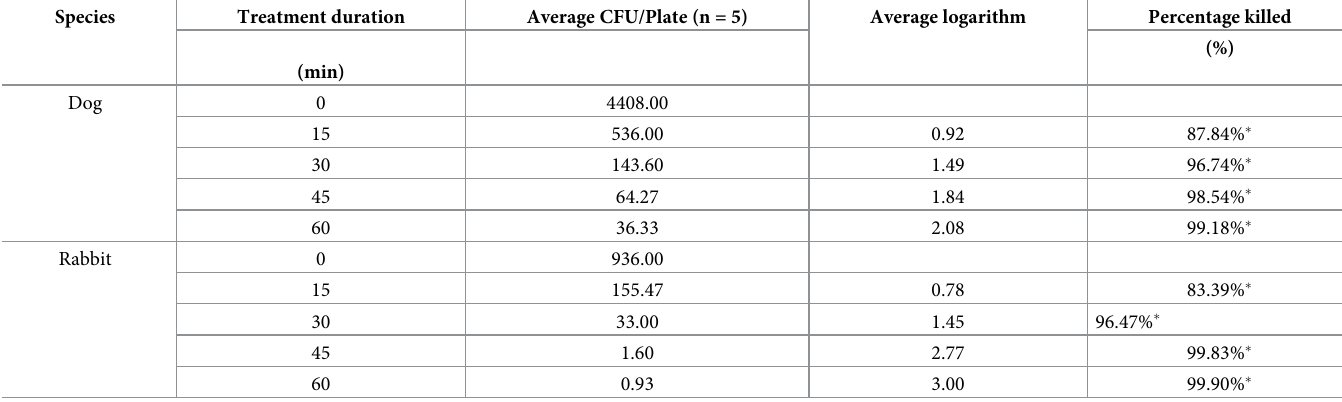
Table 2. The effectiveness of ozone treatment on the bacteria in dog and rabbit feces. Species